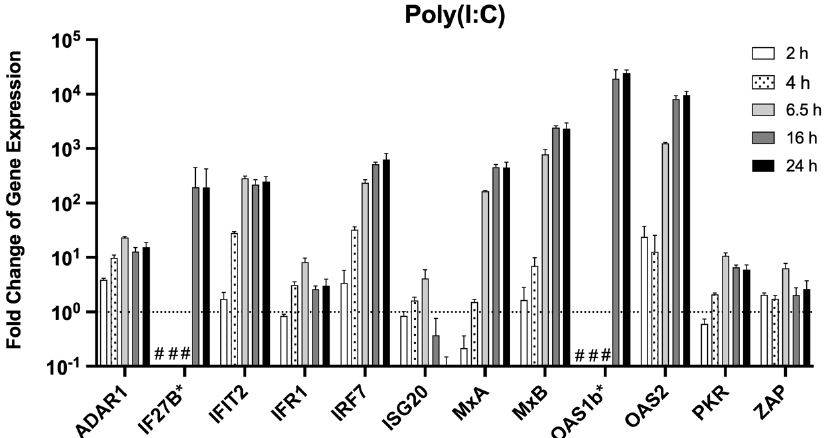
Figure 2. Changes in ISG expression after stimulation of M Φ s with Poly(I:C). M Φ s were stimulated with 1 µ g/mL Poly(I:C) or PBS for the untreated controls for 2, 4, 6.5, 16, or 24 h. Cellular RNA was isolated and depleted of DNA. For the RT-PCR-based assays, 10 ng of overall extracted RNA were used. Normalisation was performed with the ∆∆ Ct method with the housekeeping gene Ppil4. Genes were marked with an asterisk (*) if no signal Ct value for the controls was obtained due to low concentrations in unstimulated cells. The previously determined cut-off Ct values (Table 2) were used to calculate the fold change of ISG expression of these genes. (#) no Ct values were obtained for the experimental or control-treated cells, and a calculation of the fold change of expression was not feasible. The dashed line indicates the ISG level of untreated control cells. The experiment was performed in triplicate. Shown are the mean and standard deviation.